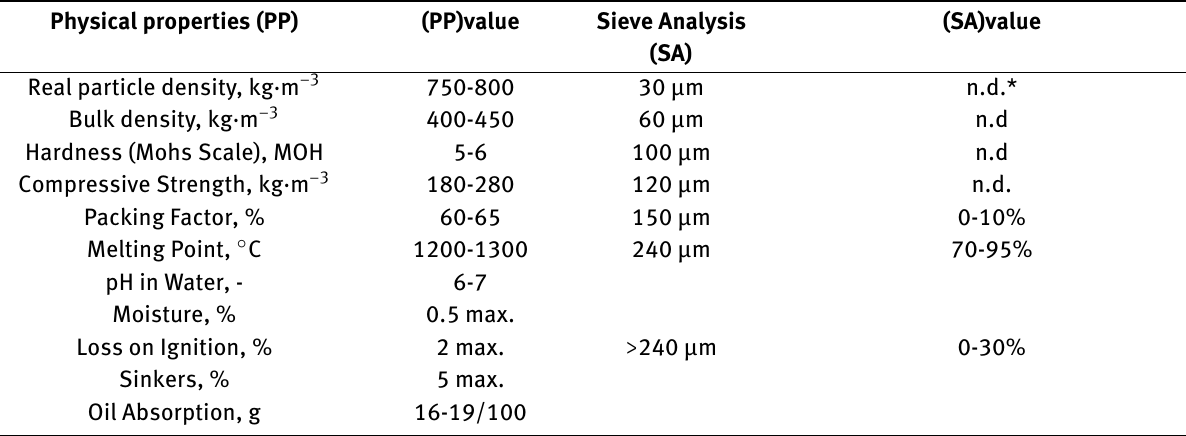
Table 1: Properties of cenospheres and grain analysis [1,